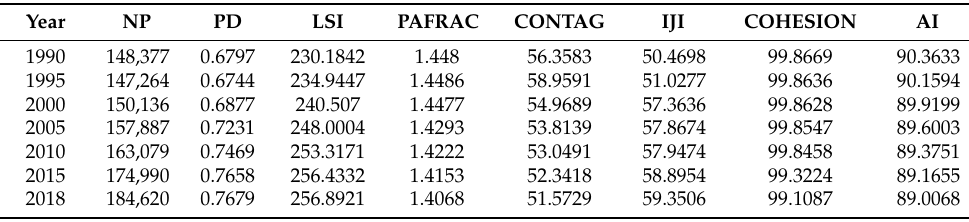
Table 6. Landscape pattern